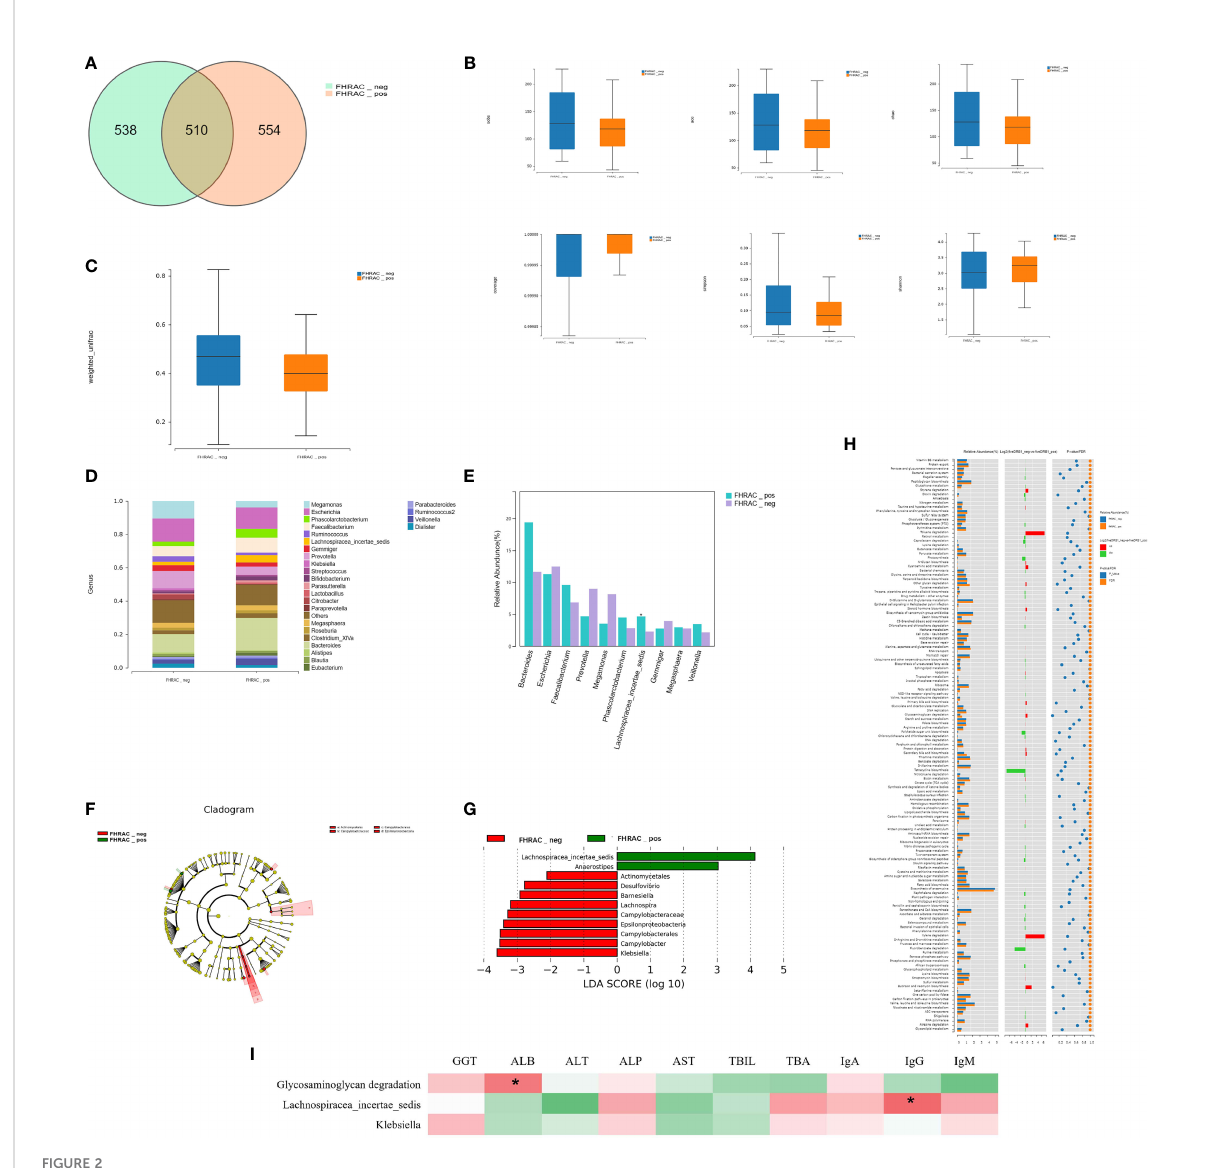
FIGURE 2 Bacterial richness and diversity analysis. (A) We found 510 shared universal OTUs in samples from both FHRAC-positive and FHRAC-negative patients. FHRAC-positive patients contained more unique OTUs than did FHRAC-negative patients (554 vs. 538 OTUs). (B) a -diversity analysis showed no signi fi cant differences in the Simpson ’ s, Shannon ’ s, Sobs, abundance-based coverage estimator (ACE), Chao, or other observed species indexes between the two groups ( P > 0.05). (C) Microbial community diversity in the FHRAC-positive patients was signi fi cantly lower than that of the FHRAC-negative patients ( P < 0.05). (D) Twenty-seven microbial genera were detected. In FHRAC-positive patients, Bacteroides , Escherichia , Others, Faecalibacterium , Phascolarctobacterium , Prevotella , Lachnospiraceae incertae , Megamonas , Veillonella , and Megasphaera were the top genera, constituting 79% of the taxa. Escherichia , Others, Bacteroides , Megamonas , Prevotella , Faecalibacterium , Gemmiger , Ruminococcus , Megasphaera and Citrobacter were the top genera in the FHRAC-negative patients (78%). (E) The Wilcoxon test was used to compare the signi fi cantly different top 10 genera. Lachnospiraceae_incertae_sedis was higher in FHRAC-positive patients than in FHRAC-negative patients. (F) linear discriminant analysis (LDA) effect-size (LEfSe) analysis showed that FHRAC-negative patient samples contained mainly Epsilonproteobacteria at the class level, Campylobacterales and Actinomycetales at the order level and Campylobacteraceae at the family level. (G) Lachnospiraceae_incertae_sedis , Anaerostipes , Actinomycetales , Desulfovibrio , Barnesiella , Lachnospira , Campylobacteraceae , Epsilonproteobacteria , Campylobacterales , Campylobacter , and Klebsiella were differentially expressed among the taxonomic levels. (H) We detected 157 metabolites or pathways at the KEGG level 3. The Wilcoxon test was used to compare the signi fi cantly different features. The differentially expressed microbiota were closely related to four differential metabolic pathways, including glycosaminoglycan degradation. (I) The Spearman ’ s correlation coef fi cient showed an association between clinical manifestations and microbial taxa. Glycosaminoglycan degradation was positively correlated with albumin (ALB). Lachnospiraceae_incertae_sedis was positively correlated with IgG.